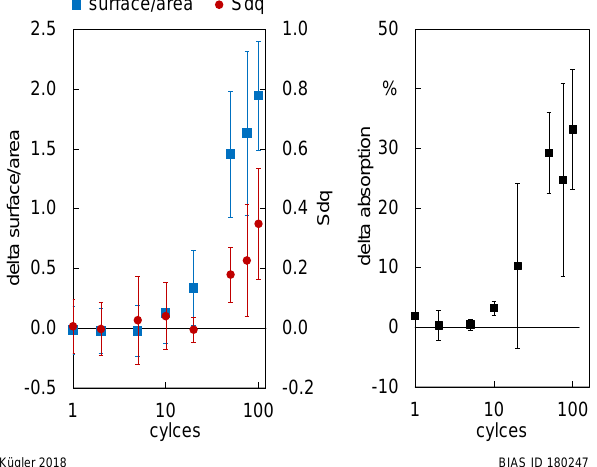
Figure 9. The effects of laser processing cycles on the hybrid roughness value Sdq , the topography